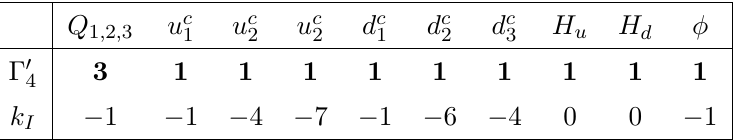
Table 4. The representations and the modular weights of the quarks. This is an explicit model for superpotential with Yukawa coupling of 3 in S 0 4